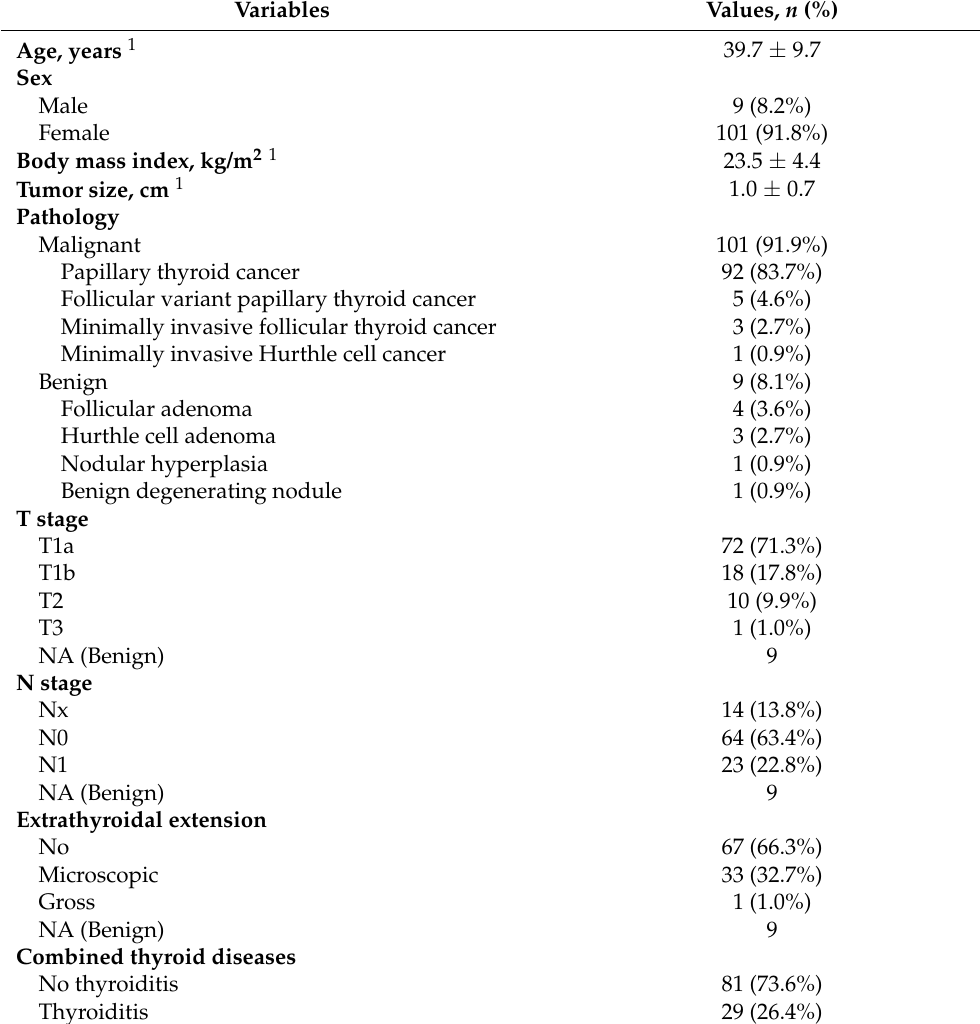
Table 1. Clinicopathologic characteristics of